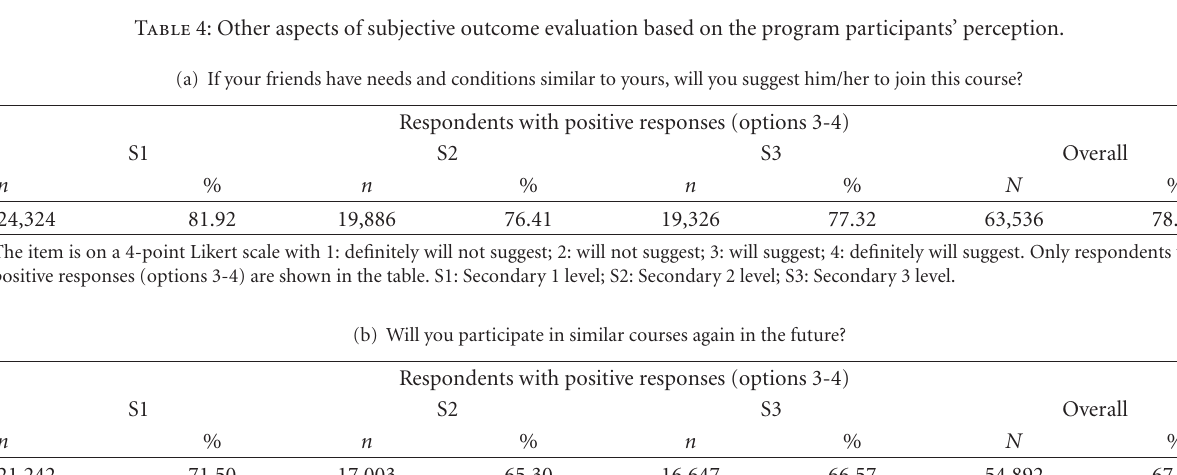
Table 4: Other aspects of subjective outcome evaluation based on the program participants’